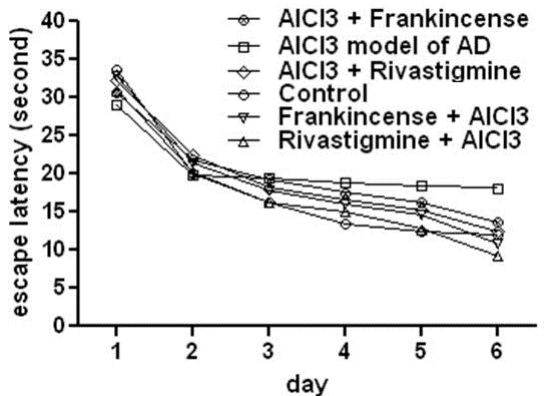
Fig. 1. Escape latency parameter: The graph presents the six-day score recorded for six tested groups in Morris Water Maze. The results reported as means ± SD.